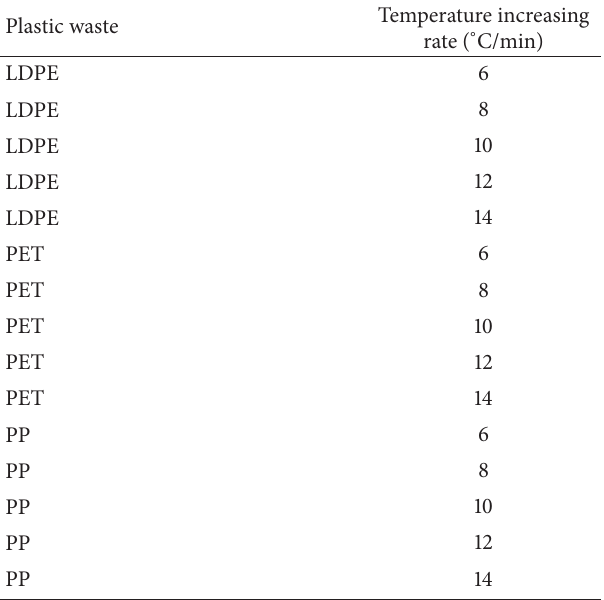
Table 2: Table of experiments used for pyrolysis of plastic wastes.